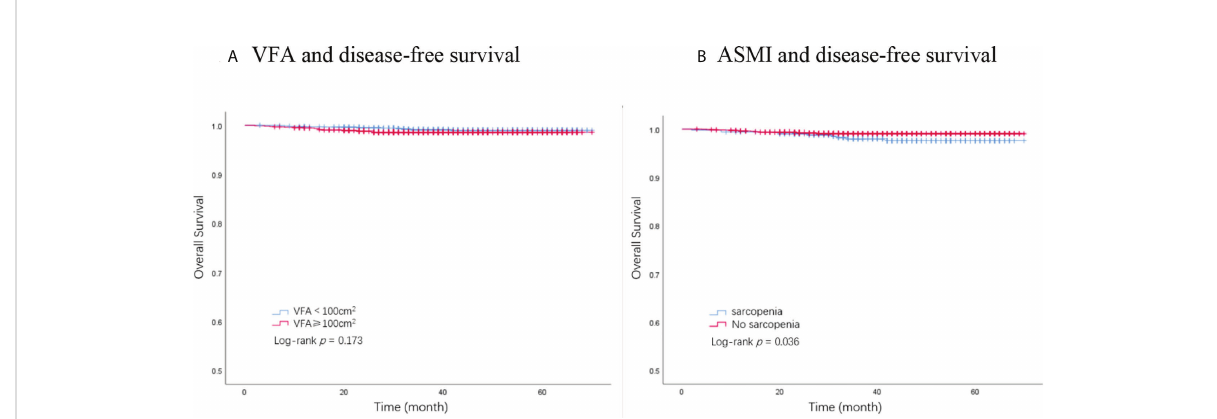
FIGURE 2 Kaplan – Meier plot of overall survival by VFA and ASMI. (A) VFA and disease-free survival. (B) ASMI and disease-free survival. VFA, visceral fat area; ASMI, appendicular skeletal muscle